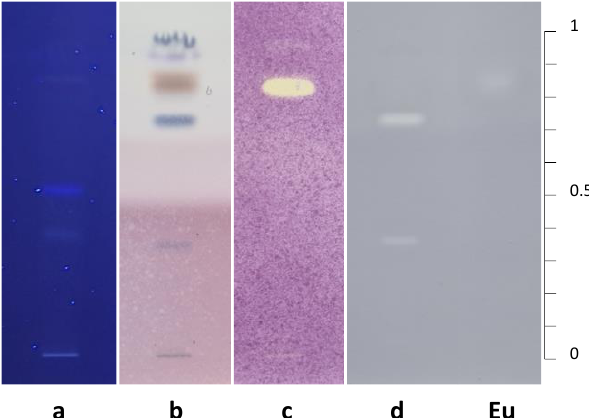
Figure 4. TLC plates of clove ( Syzygium aromaticum ) EtOAc extract (50 µg). Detection ( a ) under UV at 366 nm, ( b ) with vanillin-sulfuric acid reagent, ( c ) with DPPH, ( d ) with COX-2/arachidonic acid/TMPD, (Eu) eugenol revealed with COX-2/arachidonic acid/TMPD.